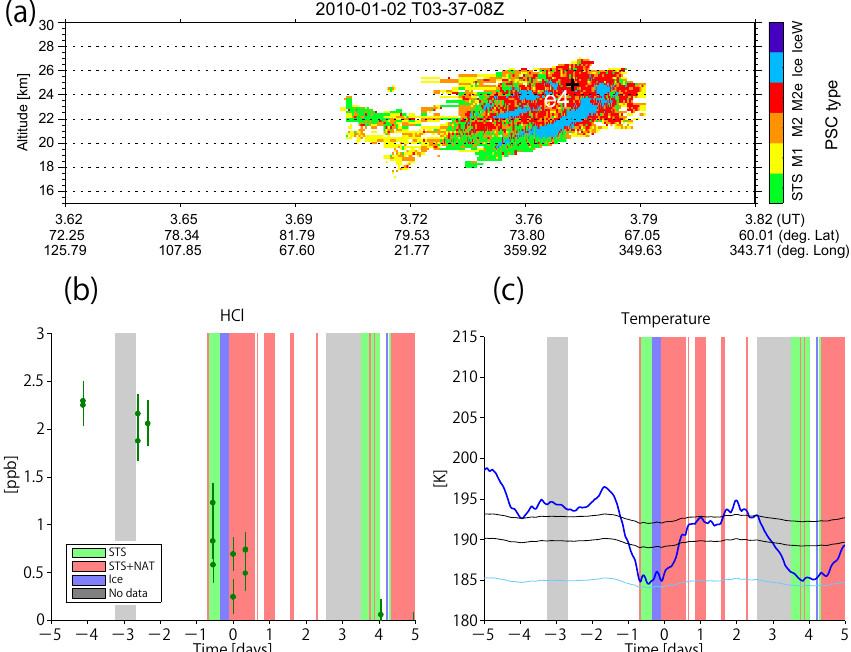
Figure 4. Same as Fig. 3 but for 2 January 2010 from 03.62 to 03.82UTC. The cross with “e4” denotes the starting point of forward/backward trajectories where Mix 2 enhanced PSC was